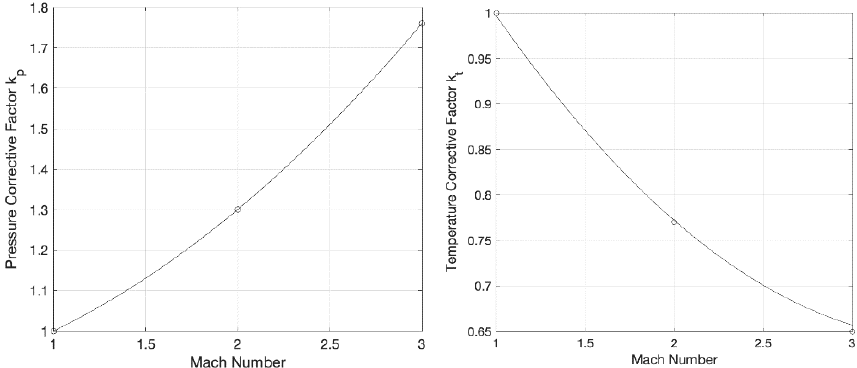
Figure 3. Pressure and temperature corrective factors as function of the Mach number.